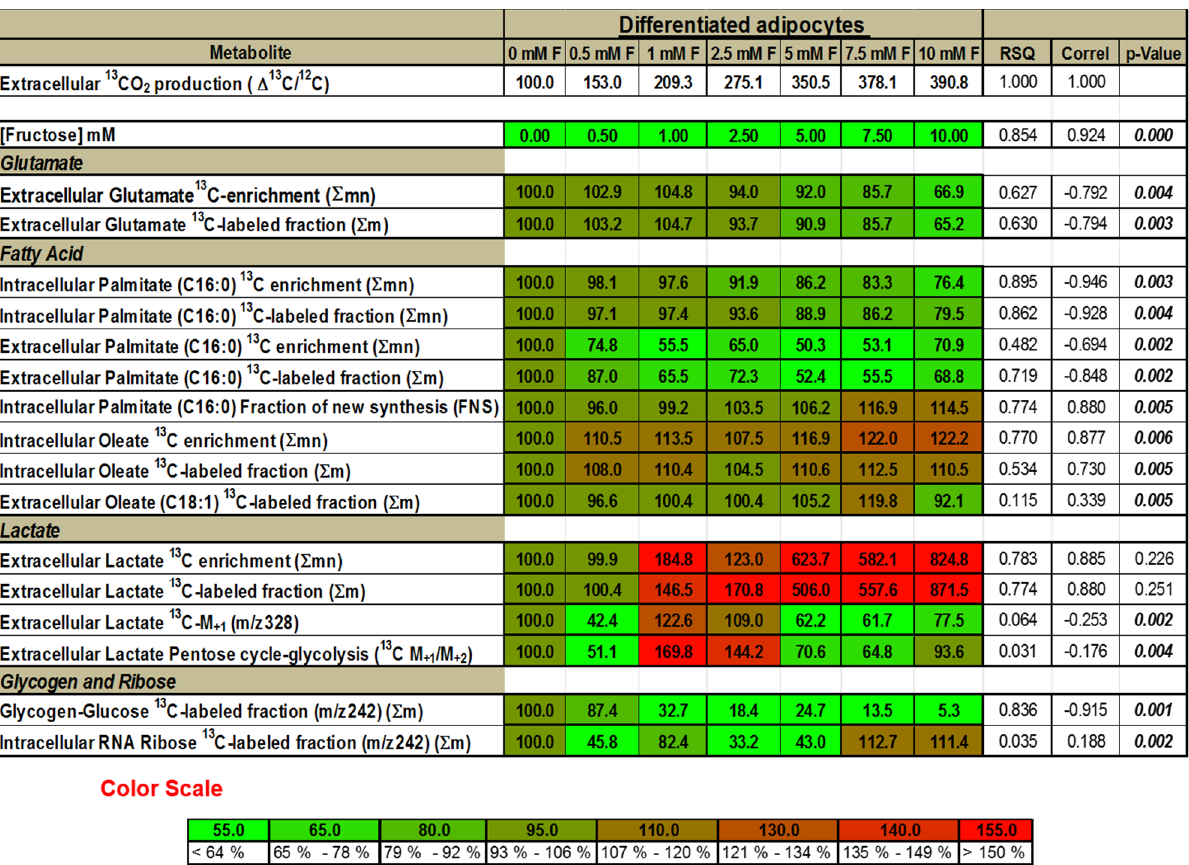
Figure 4. Correlation of the SGBS adipocyte 13 C isobolome (dependent variables) in response to glucose derived 13 C delta in CO 2 (independent reference variable). SGBS adipocyte isobolome (representing the adipocyte 13 C labeled metabolome)-wide associations in a heat map using the [1,2– 13 C 2 ]- D -glucose flux surrogates, are examined for correlation with glucose derived 13 CO 2 production across different fructose concentrations. The figure presents regression statistics by the coefficient of determination (RSQ), correlation coefficients (correl, R) and p values for the numeric percent changes among groups (please see Methods) of the adipocyte 13 C isotopomers and glucose derived 13 C CO 2 production. The darkest green in the heat map represents 100% with the lighter green shades representing decreasing % values and the brighter red shades representing increasing %